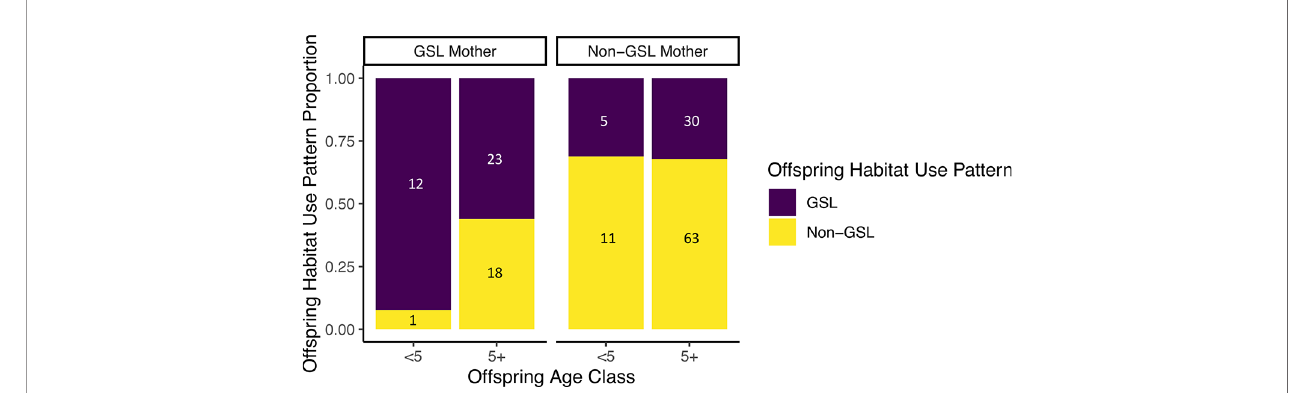
FIGURE 6 | Comparison of habitat use patterns between mothers and their offspring, with offspring categorized by age and parsed by the habitat usage pattern of their mother. The x-axis labels correspond to the individual whale ’ s age in 2019, where “ Age < 5 ” represents offspring younger than fi ve, and “ Age 5+ ” represents offspring that were at least fi ve